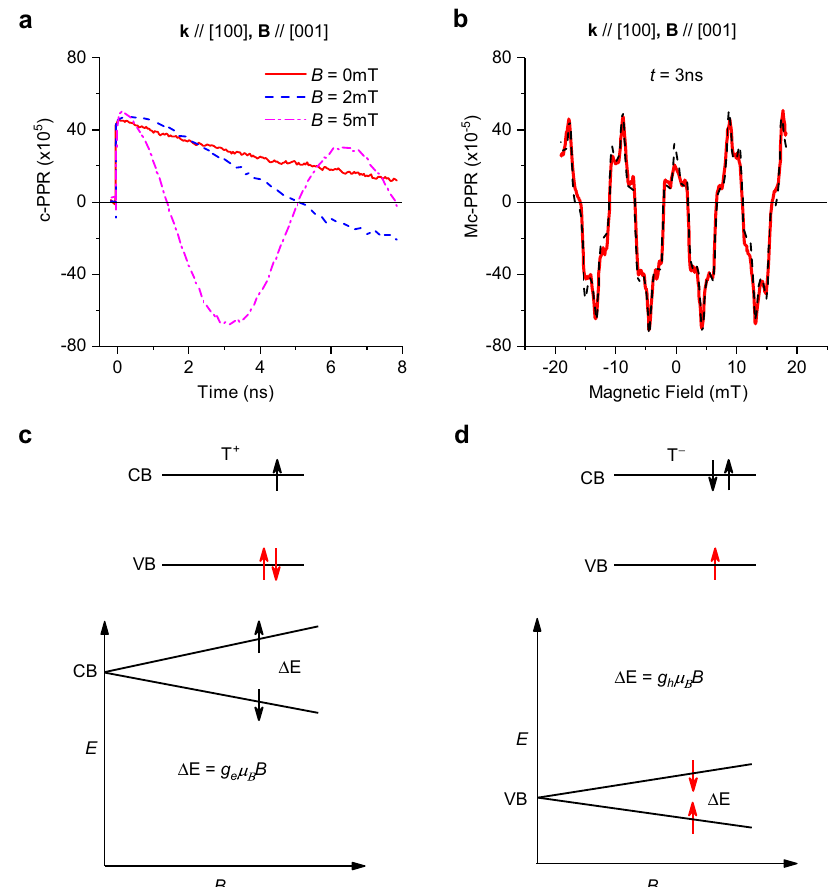
Fig. 4 Trion zero- fi eld splitting and Zeeman splitting, and their related quantum beatings at small magnetic fi eld. a The c-PPR(t) response in MAPbI 3 measured on (100) crystal facet at 758 nm pump/probe beams at B = 0, 2 mT and 5 mT, respectively, with applied B along [001]. b The magnetic circular- PPR (Mc-PPR(B)) response measured at fi xed delay time, t = 3 ns (black dashed line) and its fi tting (red line) using Eq. (1). c and d Schematic representation of positive T + and negative T − trions and their correspondent Zeeman splitting under applied magnetic fi eld. The red (black) arrows represent the holes ’ (electrons) spin orientation. Note that the Zeeman splitting is determined by the single particle in the trion since the two spins of the like particles are antiparallel to each